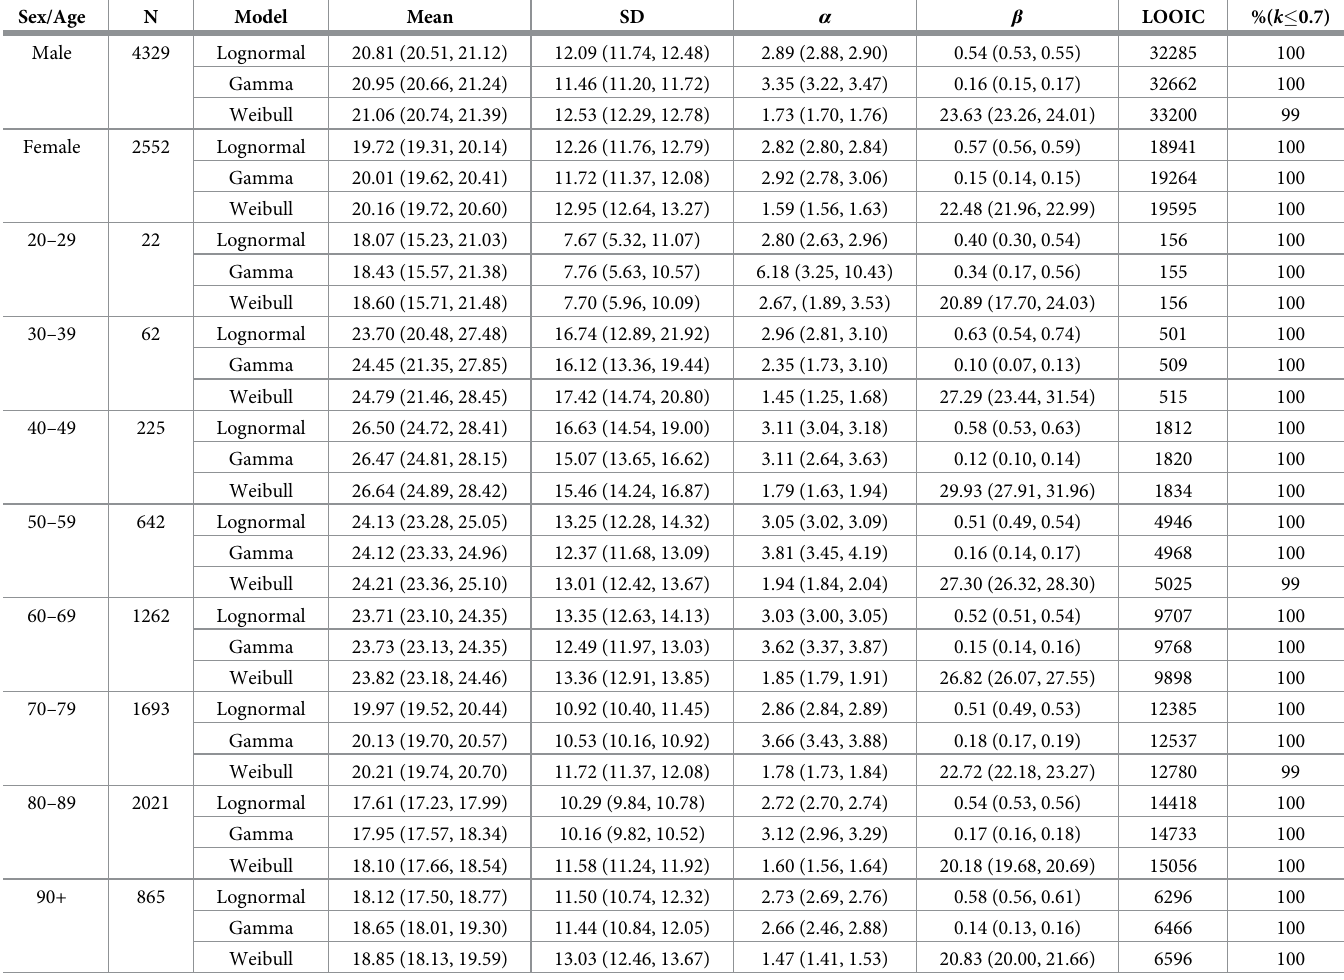
Table 7. Results for the time from infection to death by sex and